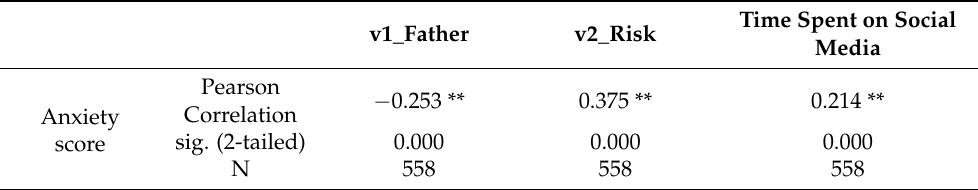
Table 5. Father–adolescent relationship, exposure to risk, and time spent on social media scores.